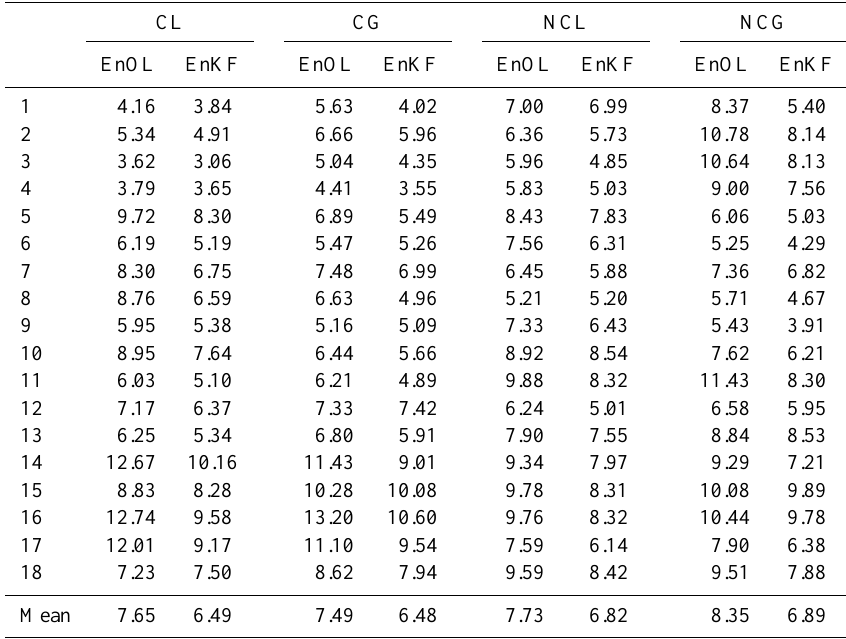
Table 5. RMSE (mm) computed between monthly mean estimated GW variation and monthly mean in situ variation. Names of the stations (first column) are provided in Appendix